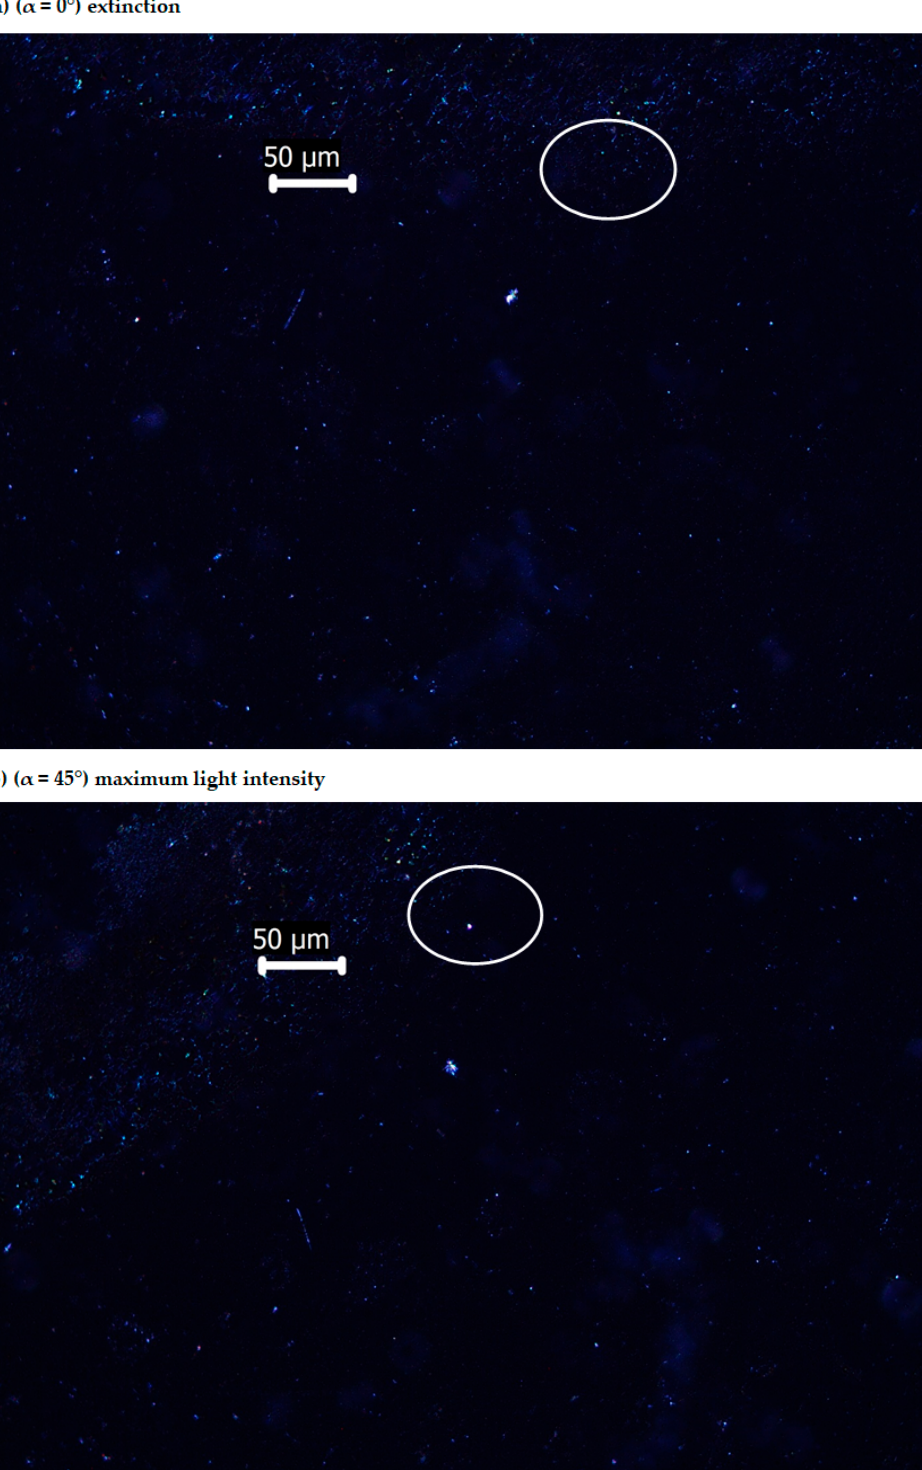
Figure 10. Optical images of BPA ( c = 1%) with crossed polarizers.